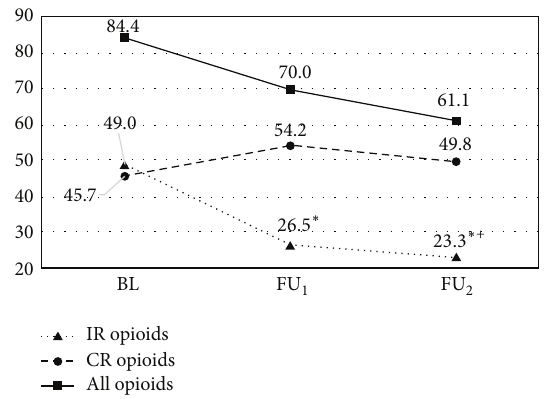
Figure 3: Average morphine equivalent daily dose (mg/day). ∗ Comparison with baseline. Paired-samples 𝑡 -test 𝑝 < 0.005 . + Comparison between IR (immediate release) and CR (controlled release) opioids. Independent-samples 𝑡 -test 𝑝 < 0.005 .